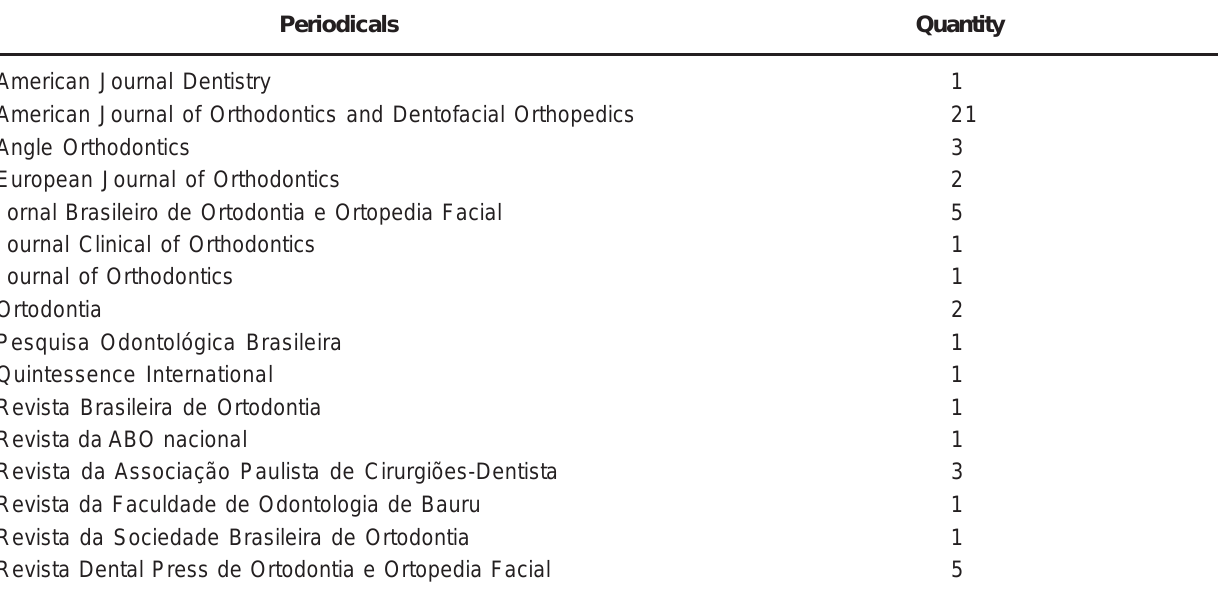
TABLE 1 - Periodicals from which the articles were